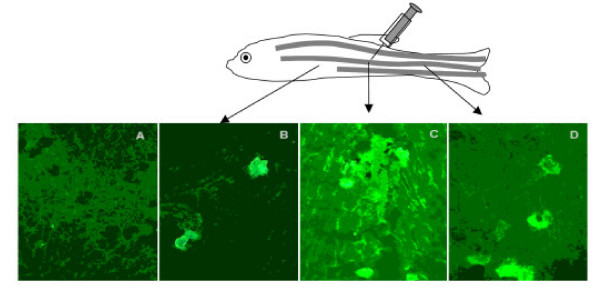
Effect of electroporation on GFP expression in zebrafish. Fluorescence images from control (A) and electroporated samples (B, C and D). (A) is an image taken from the tissue at the site of injection. B, C and D represent the images obtained from head, mid-region and tail respectively. Fluorescence from tissue sections from head and tail of control fish is similar to (A), hence not shown. At least 20 fish were electroporated in different days with pCMVGFP. We observe some variation in extent of GFP expression but the expression was always maximum in the mid-region. The presented data is from one fish.